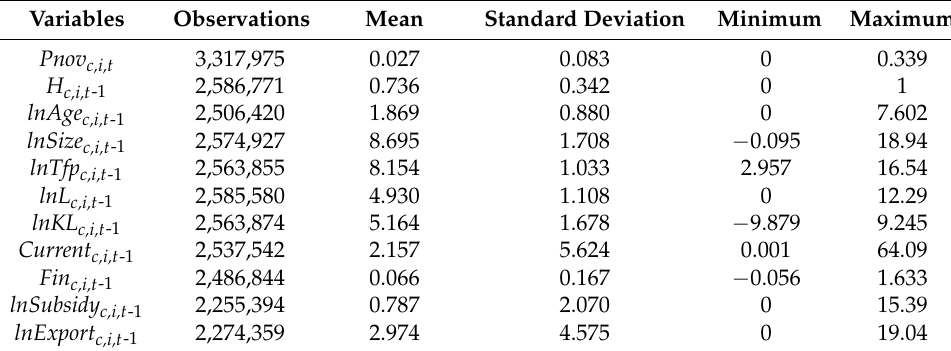
Table 3. Descriptive statistics of main